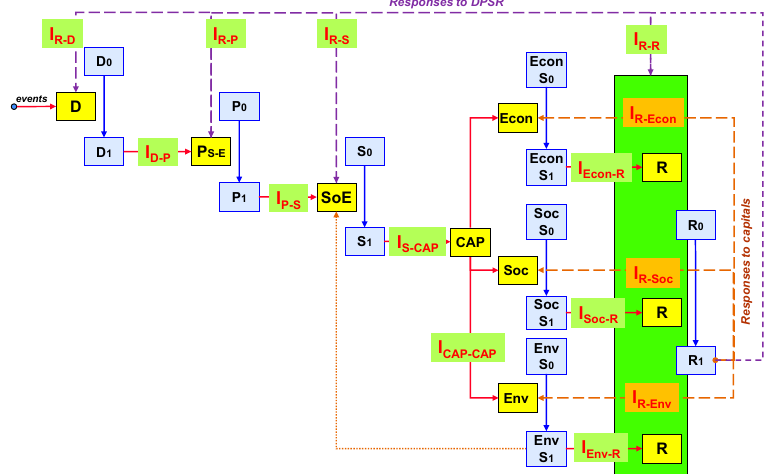
Figure 4. Extended DPSIR scheme. For each DPSIR factor, effects are shown as changes of the initial condition (0) to the final condition (1). Effects result from impacts between successive DPSIR factors. Impacts on the societal capitals are emphasized by showing the economic (Econ), social (Soc), and environmental (Env, or natural) capitals. Some impacts are secondary ‘natural’ (intrinsic, systemic) reactions of (parts of) capitals on impacted capitals (ICAP-CAP). Changing conditions force policy to respond, by addressing the capitals themselves (IR-CAP) or by influencing the disturbance process, i.e., drivers (IR-D), pressures (IR-P), and status (IR-S) conditions. Driving forces can be influenced by either policy responses or external events. Most challenging is to keep pace with increasing environmental complexity by questioning the responses themselves (IR-R), gradually moving towards an adapted form of policy and management (R0 → R1). (Solid lines show straight impacts between DPSIR factors, dashed lines show responses between societal capitals and DPSIR factors; the dotted line indicates secondary environmental status (SoE) impacts).